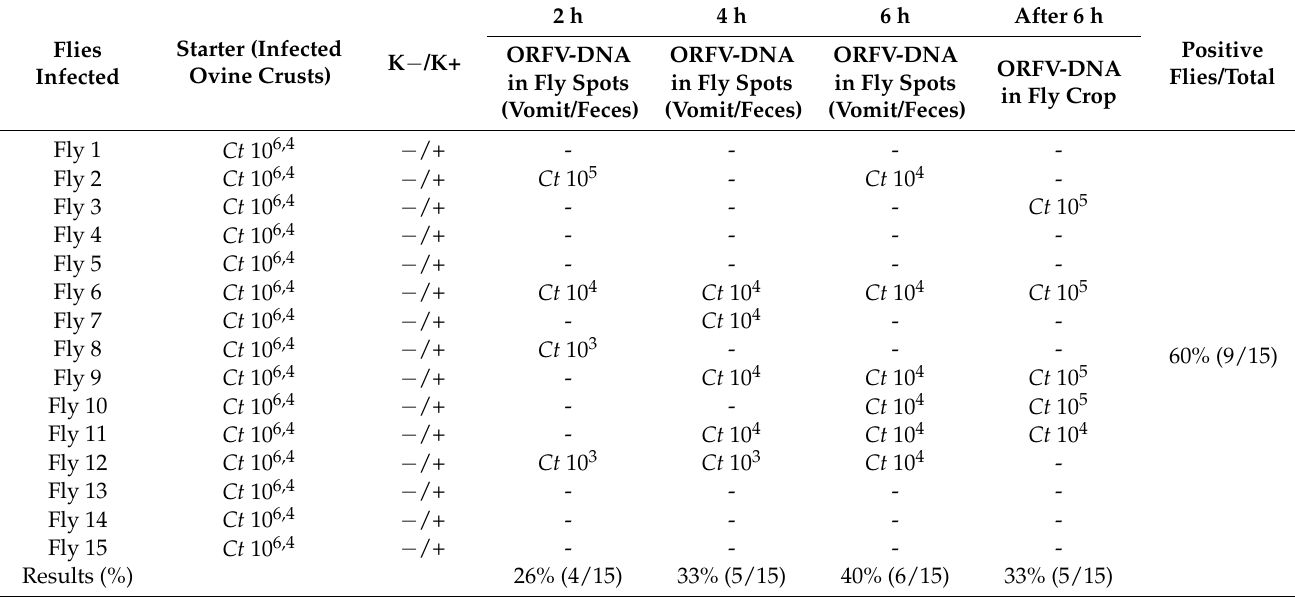
Table 1. Experiment 3: Detection of ORFV-DNA using RT-PCR in housefly spots and crops. Fly spots were examined at 2 h, 4 h and 6 h after the infective feed. Ct = copy